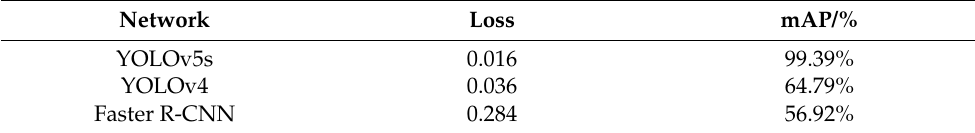
Table 2. Performance comparison of Y6OLOv5s, YOLOv4, and Faster R-CNN. Network